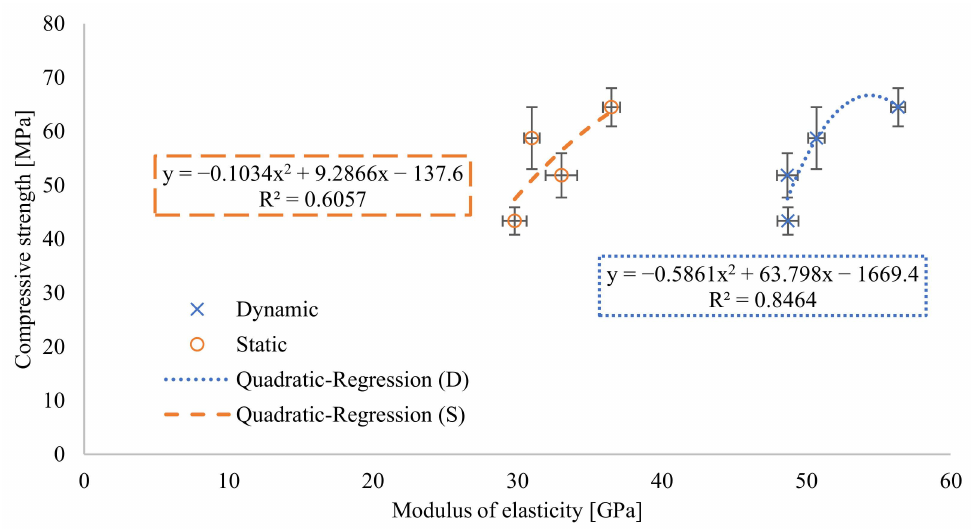
Figure 8. Quadratic regression analysis of the relationship between modulus of elasticity and compressive strength (D = Dynamic, S = Static).